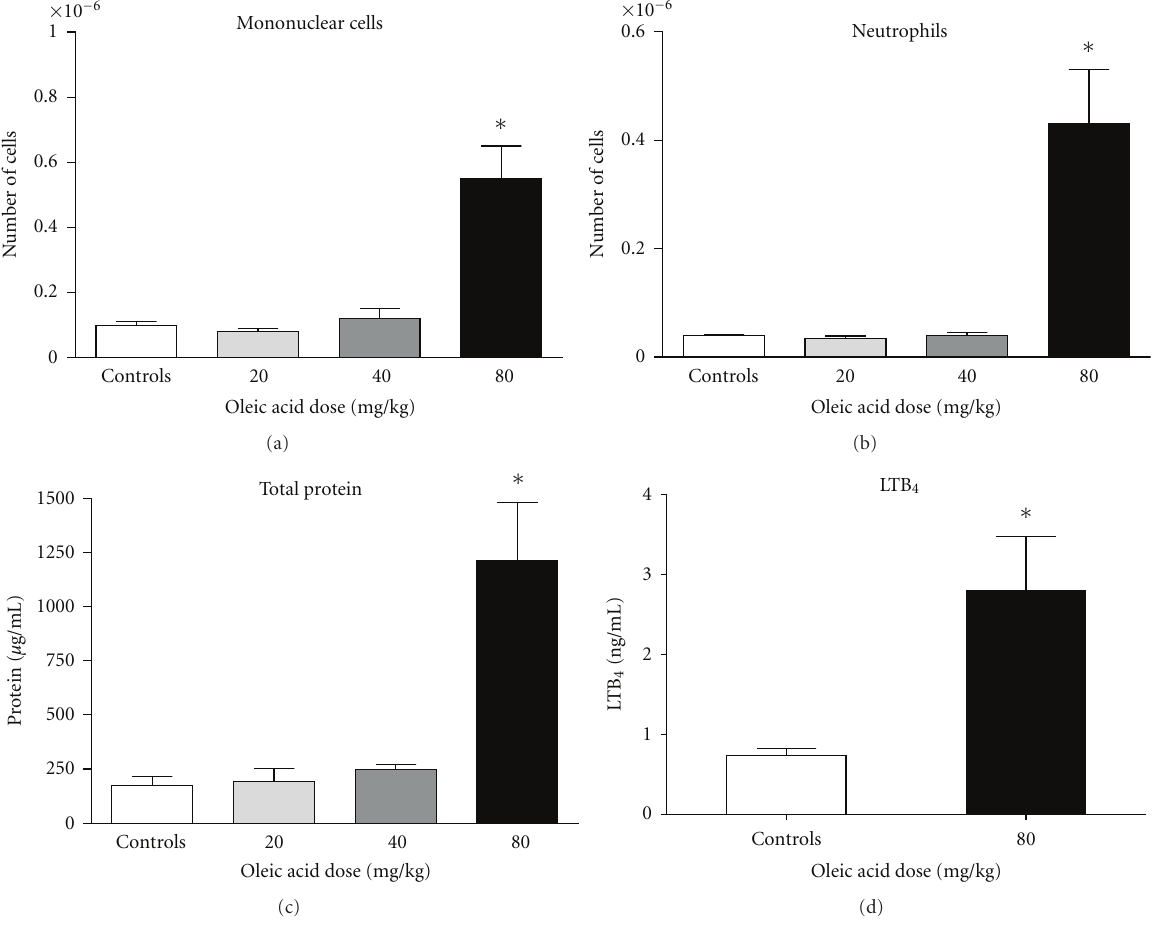
Figure 2: Leukocyte migration, protein extravasation, and LTB 4 production in BALF after intravenous OLA injections. Mononuclear cells, neutrophils, and total protein (in BALF supernatants) were measured 24 h after injections, while LTB 4 was assayed in supernatants 6h after injections. Results represent the mean ± SEM of 3 independent experiments. ∗ P < 0 .